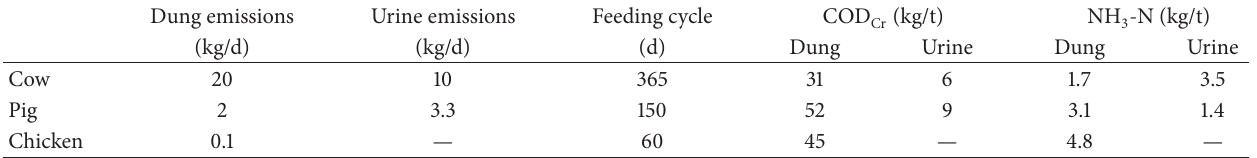
Table 3: The fecal excretion coefficient and the average content of pollutants.